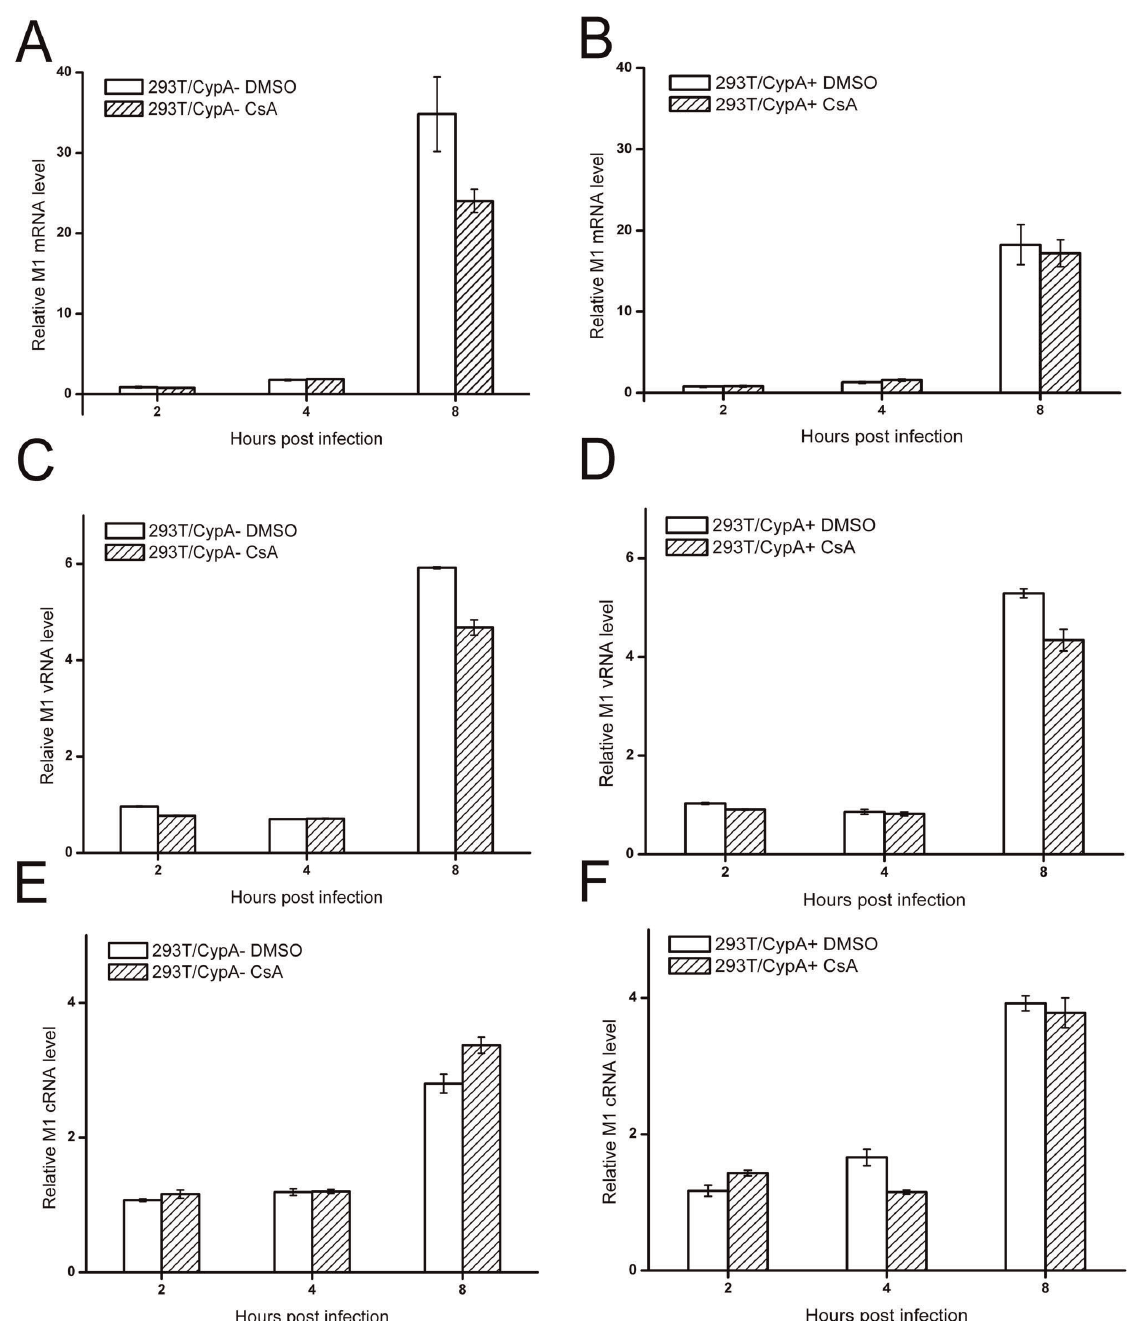
Figure 4. CsA inhibited the influenza virus replication at post-transcriptional level. 293T/CypA 2 and 293T/CypA + cell lines were infected with influenza A/WSN/33 (MOI=1) in the absence or presence of CsA (5 m g/ml). RNA of the infected cells at 2 h, 4 h and 8 h p.i. was extracted and assayed using the specific primers for influenza RNA by RT-PCR. The M1 mRNA level (A and B), vRNA level (C and D) and cRNA level (E and F) of the both cell lines were quantified by real-time PCR analysis using the specific primer for M1. The mRNA of GAPDH was kept as an internal control. Data are means 6 SD of three separate experiments.